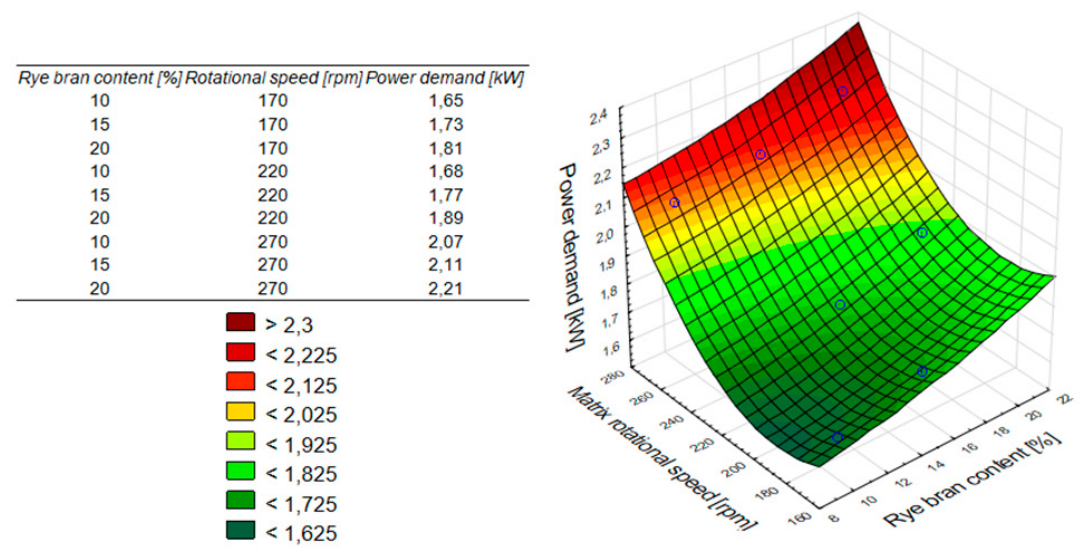
Figure 5. Influence of rye bran and rotational speed of the matrix on the granulator demand for power during the production of plum stones pellets.